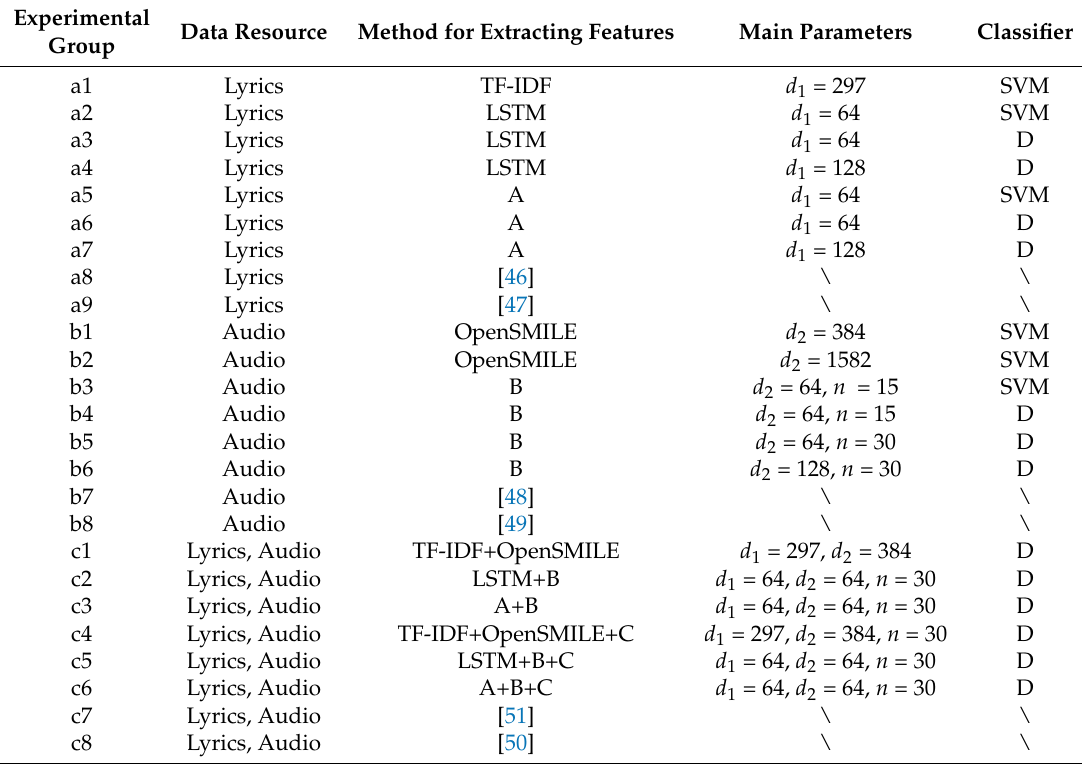
Table 2. Details of designed three experimental